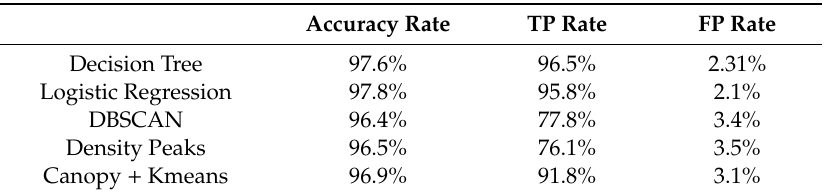
Table 6. Comparison